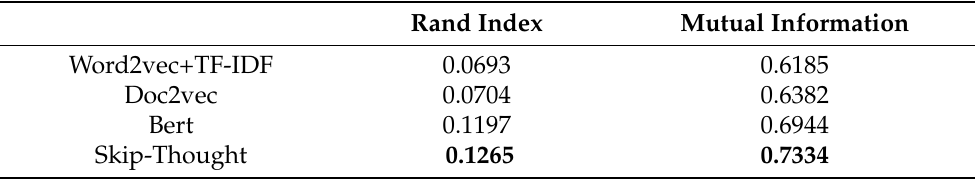
Table 3. The results of the comparison between the sentence embedding